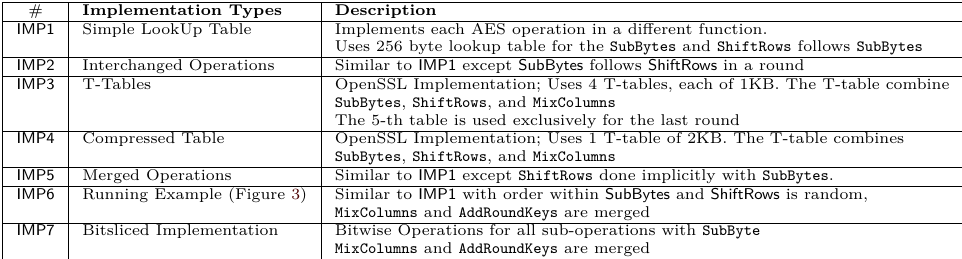
Table 2: Different Implementations of AES (all